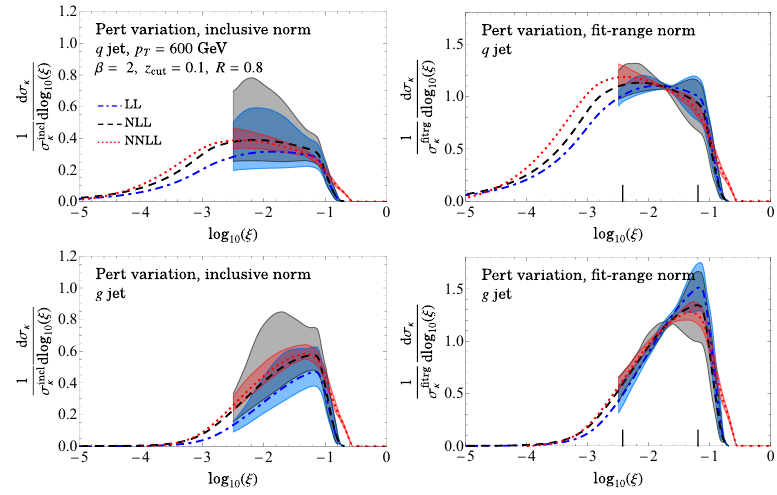
Figure 20 . An envelope of the profile variations for quark and gluon jets respectively, at LL, NLL and